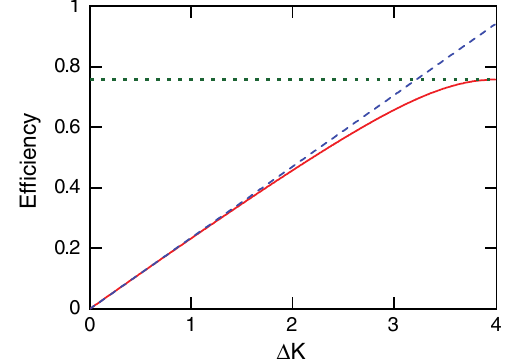
FIG. 2. Efficiency for TESSA single pass energy extraction from a relativistic electron beam in the limit of low radiation gain for K 0 ¼ 4 (red curve). The approximation in Eq. (5) is also shown (blue dashed). The maximum efficiency limit η e;m is indicated by a dotted green